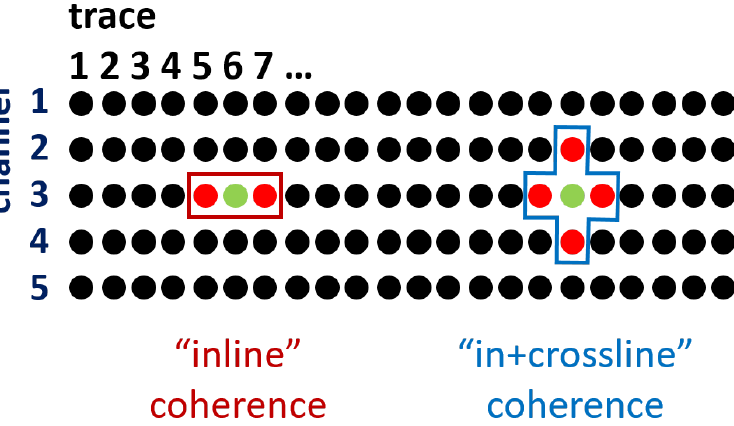
Figure 1. Top-view of the ground-penetrating radar (GPR) traces used for inline and in+crossline coherence